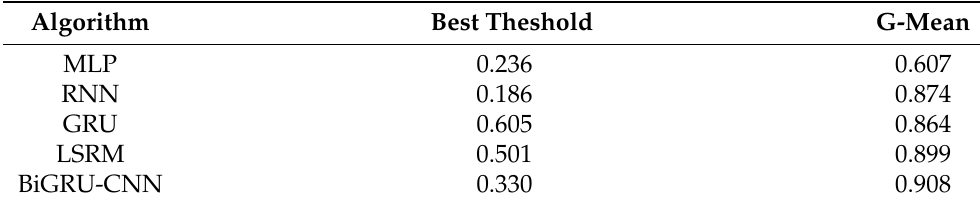
Table 2. ROC curve comparison metric of all neural networks.